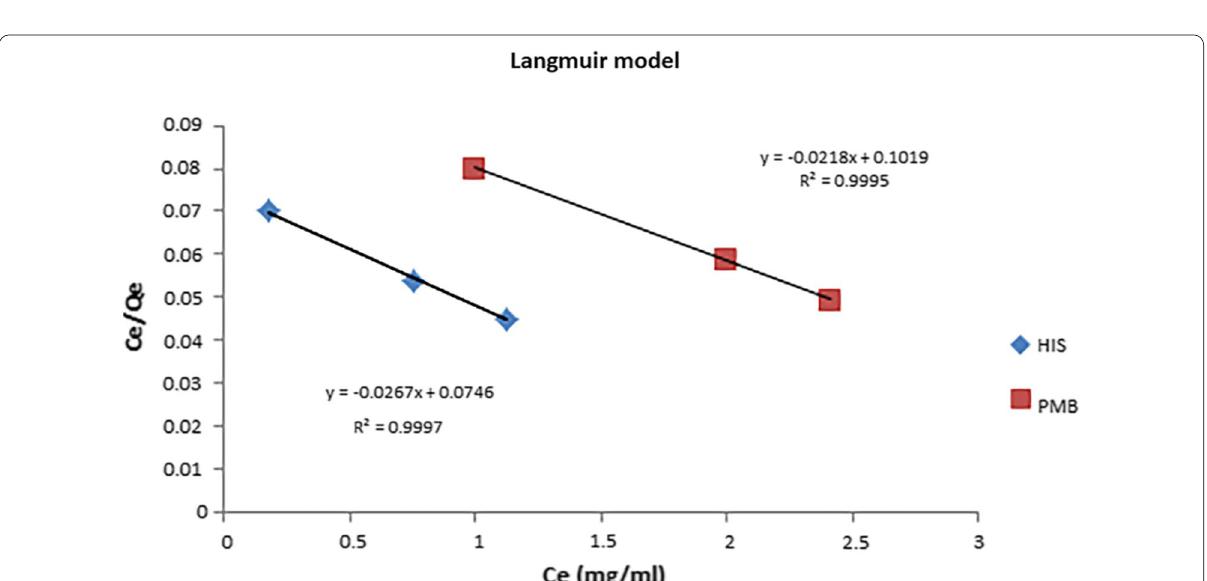
Fig. 10 Fitting of isotherm data to Langmuir model for both histidine and PMB